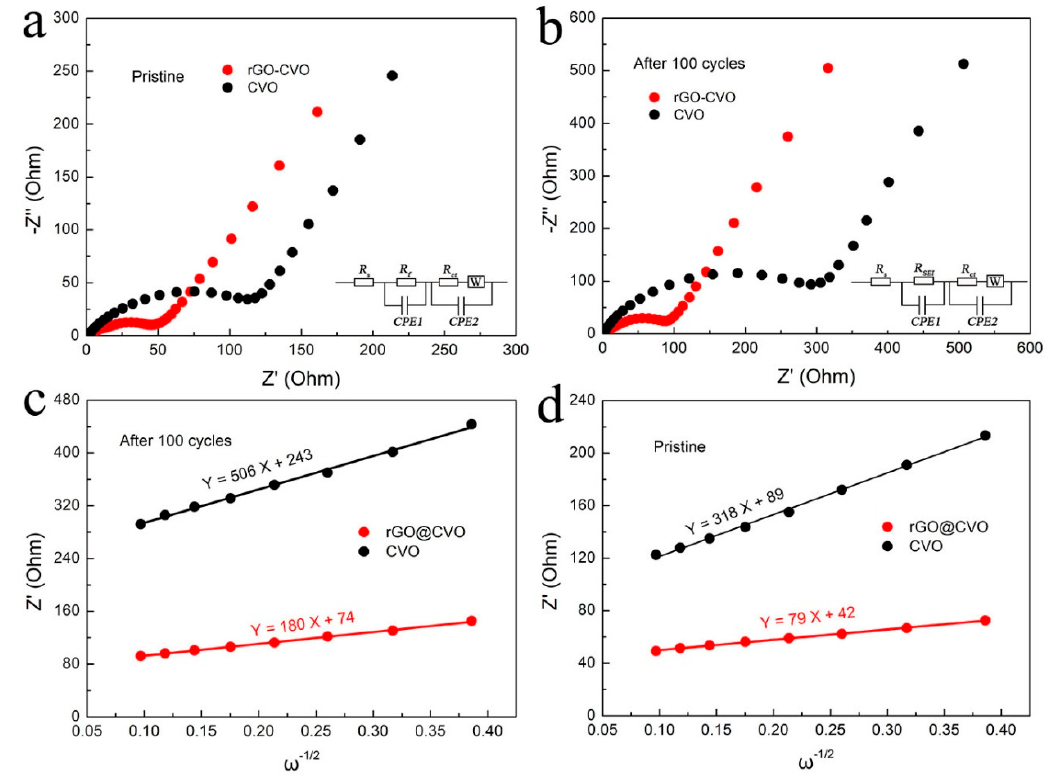
Figure 6. Nyquist plots of rGO@CVO and CVO electrodes: ( a ) pristine and ( b ) after 100 cycles; the relationship plot of the low-frequency region between Z ’ and ω − 1 / 2 : ( c ) pristine and ( d ) after 100 cycles.